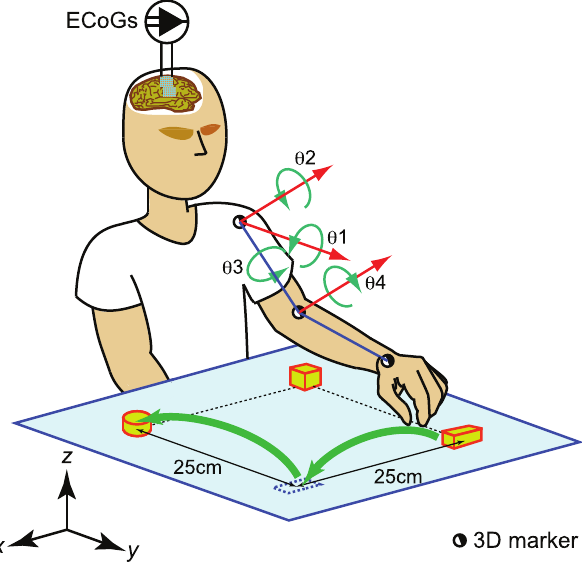
Figure 1. Behavioral tasks. Patient 1 repositioned three blocks one by one and clockwise (green arrows ) at the corners of a 25 cm 6 25 cm square. ECoG signals were obtained with planar- surface platinum grid electrodes placed on the right sensorimotor cortex. Half-closed circles on the left shoulder, elbow, and wrist joints represent three-dimensional markers for the motion capture system. The angles q1, q2, q3, and q4 are defined as an abduction/adduction angle, a flexion/extension angle, an external/internal rotation at the left shoulder joint, and a flexion/extension angle at the left elbow joint, respectively. When he lowered his arm toward the - z direction and turned his palm to the y direction with the elbow extended, q1, q2, and q3 were all zero, and q4 was p